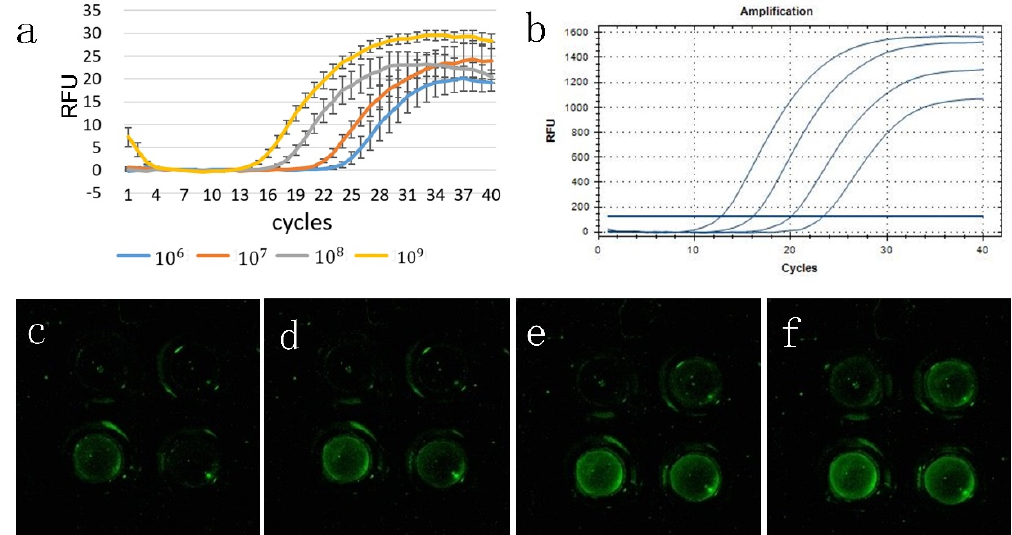
Figure 5. Gradient amplification curve on ( a ) the portable PCR system and the ( b ) commercial PCR instrument. ( c – f ) Fluorescence signal for the real-time fluorescence image acquired by the detection system when the number of cycles is 17, 20, 24, and 27, fluorescence changes of different initial concentrations of DNA that can be observed. The initial concentration is 10 6 in the lower left corner, 10 7 in the lower right corner, 10 8 in the upper right corner, and 10 9 in the upper left corner.